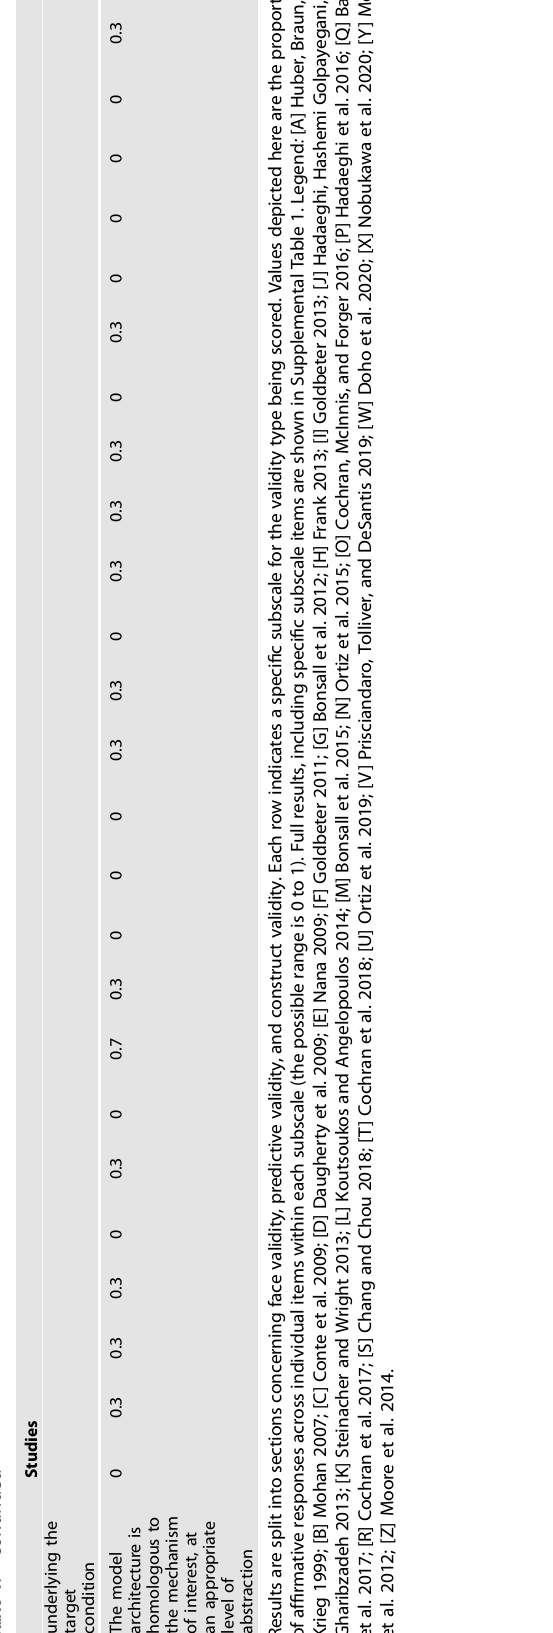
model predicts that most individuals will enter a stable periodic regime with relative insensitivity to life events, followed by multistable and chaotic regimes late in the illness. Another study proposed a set of models assuming that mania and depression were independent attractor states, between which an individual ’ s mood could oscillate [38, 42] ( κ = 0.65 and 0.43, respectively). This model proposed by Goldbeter [38] predicted that if a depressed patient were given a suf fi ciently high antidepressant dose, the system governing mood oscillations would enter the bistable region, in which a manic switch could occur. The Goldbeter [38, 42] model makes a prediction that could be experimentally scrutinized: that an individual ’ s risk